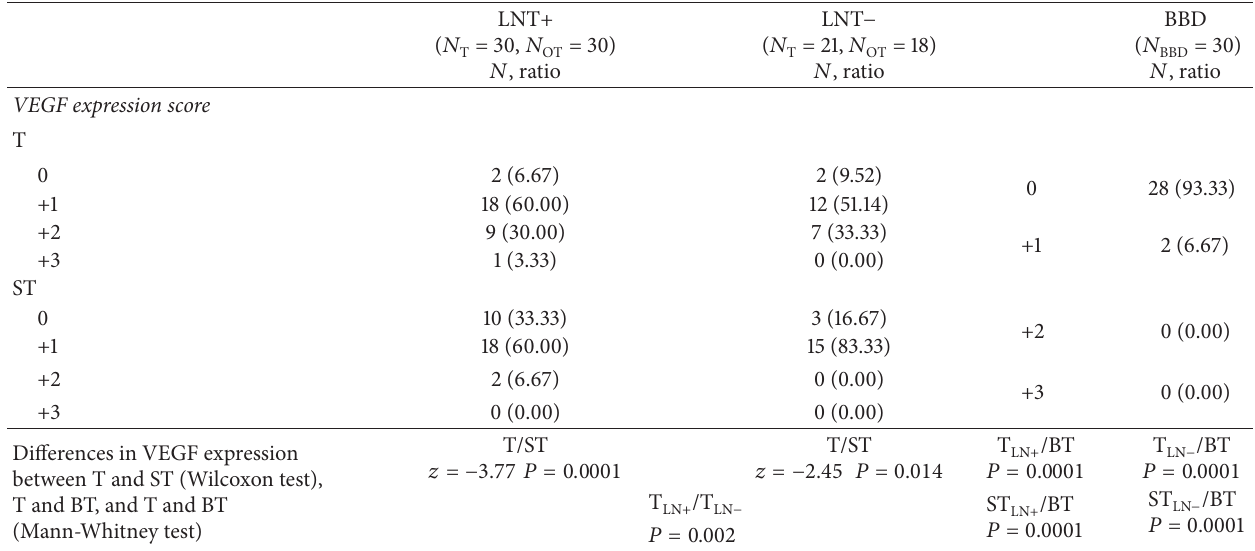
Table 1: The final score VEGF expression in breast cancer patients and in patients with benign breast disease.